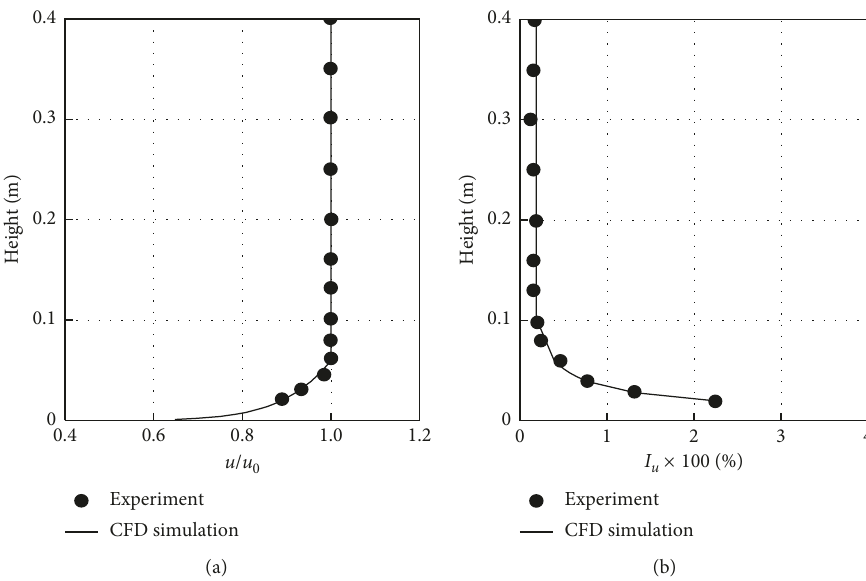
Figure 2: (a) Mean streamwise velocity and (b) turbulence intensity profiles measured at the model center.